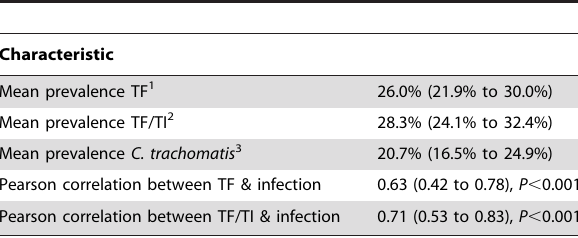
Table 2. Characteristics in children aged 0–5 years in 48 communities in Niger.